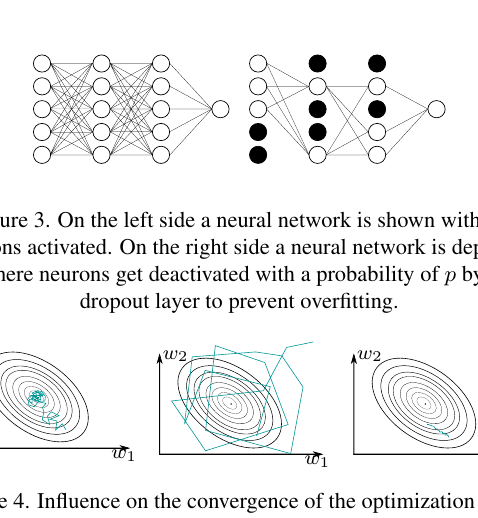
get multiplied by the dropout-probability p .